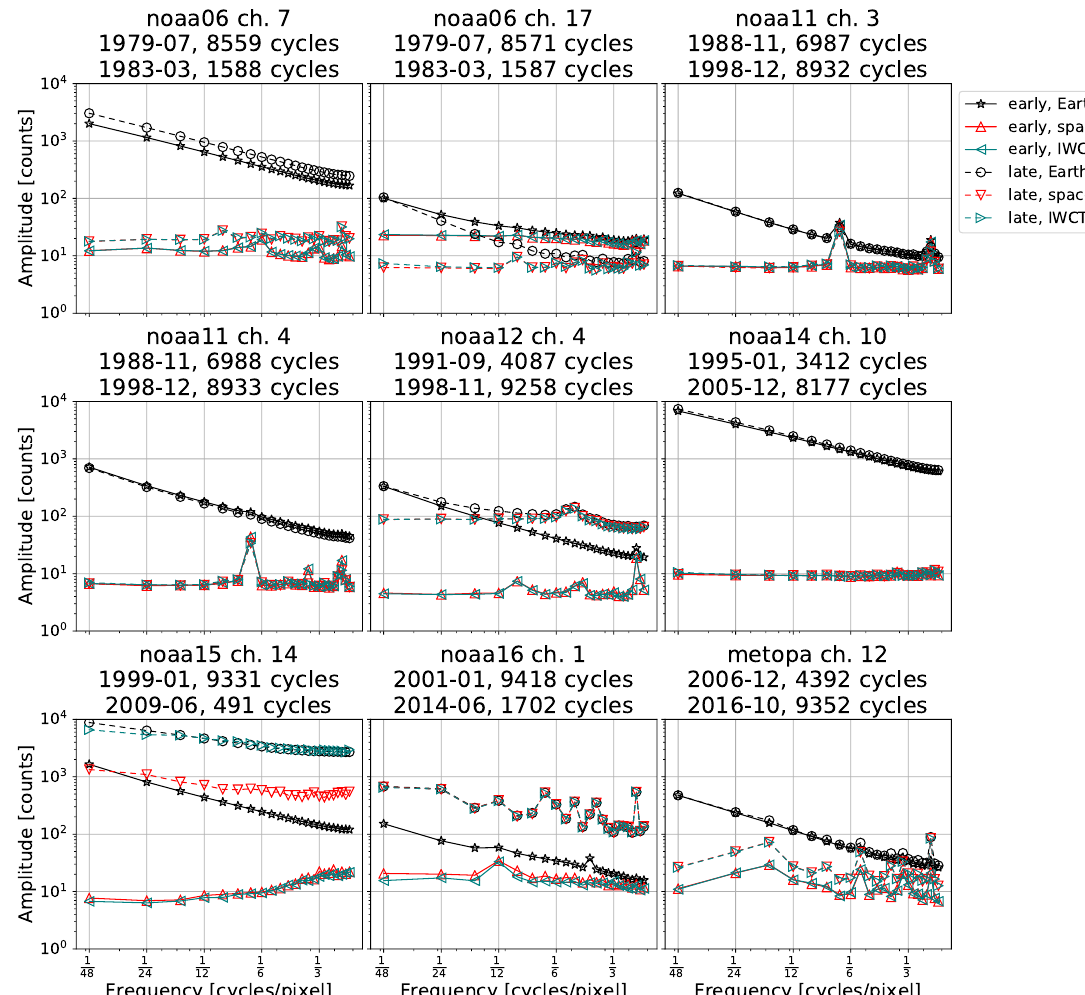
Figure 9. Time-averaged power spectrum of calibration cycles and Earth views for a selection of satellites and months. The duration of a pixel is 0.1s, so a peak near 1 cycles/pixel corresponds to 6 periodic error with a period of 0.6s. Each panel shows the average power spectrum during an early month for the satellite and channel (solid lines with stars and triangles pointing up or left) and a month during a late month for the satellite (dashed lines with circles and triangles pointing down or right). Earth views are in black with stars or circle, space views are in red with up- or down-pointing triangles, and IWCT views are in teal with left- or right-pointing triangles. In most cases, Earth and IWCT views have the same mean power spectrum so their lines are indistinguishable. The text above each panel indicates the corresponding satellite, channel, period, and the number of sets of calibration measurements used to calculate the power spectrum. Note that for any particular panel, the number of sets of Earth views is a factor 37 (HIRS/2, HIRS/2I) or 38 (HIRS/3, HIRS/4) higher than the number of sets of calibration views. The red and teal lines with triangles show the mean power spectra for space and IWCT views, respectively. In most cases, the mean power spectra for space and IWCT are (nearly) identical, with